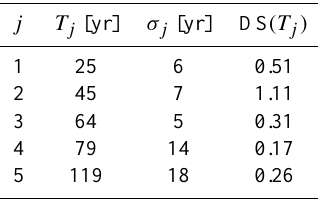
Table 1. Second and third columns list the main parameters (av- erage and standard deviation) of the Gaussian distributions used to decompose, by means of Eq. (11), the marginal spectrum H m (T ) shown in Fig. 8. Fourth column gives the value of the degree of stationarity DS for each period T j